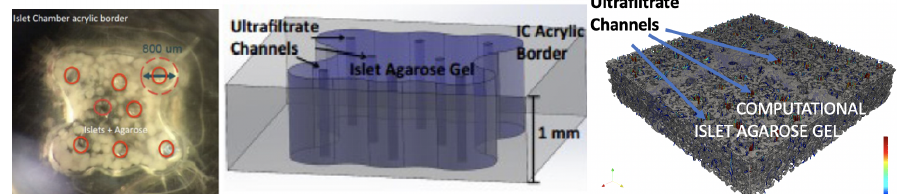
Figure 3. Ultrafiltrate channels in agarose gel.